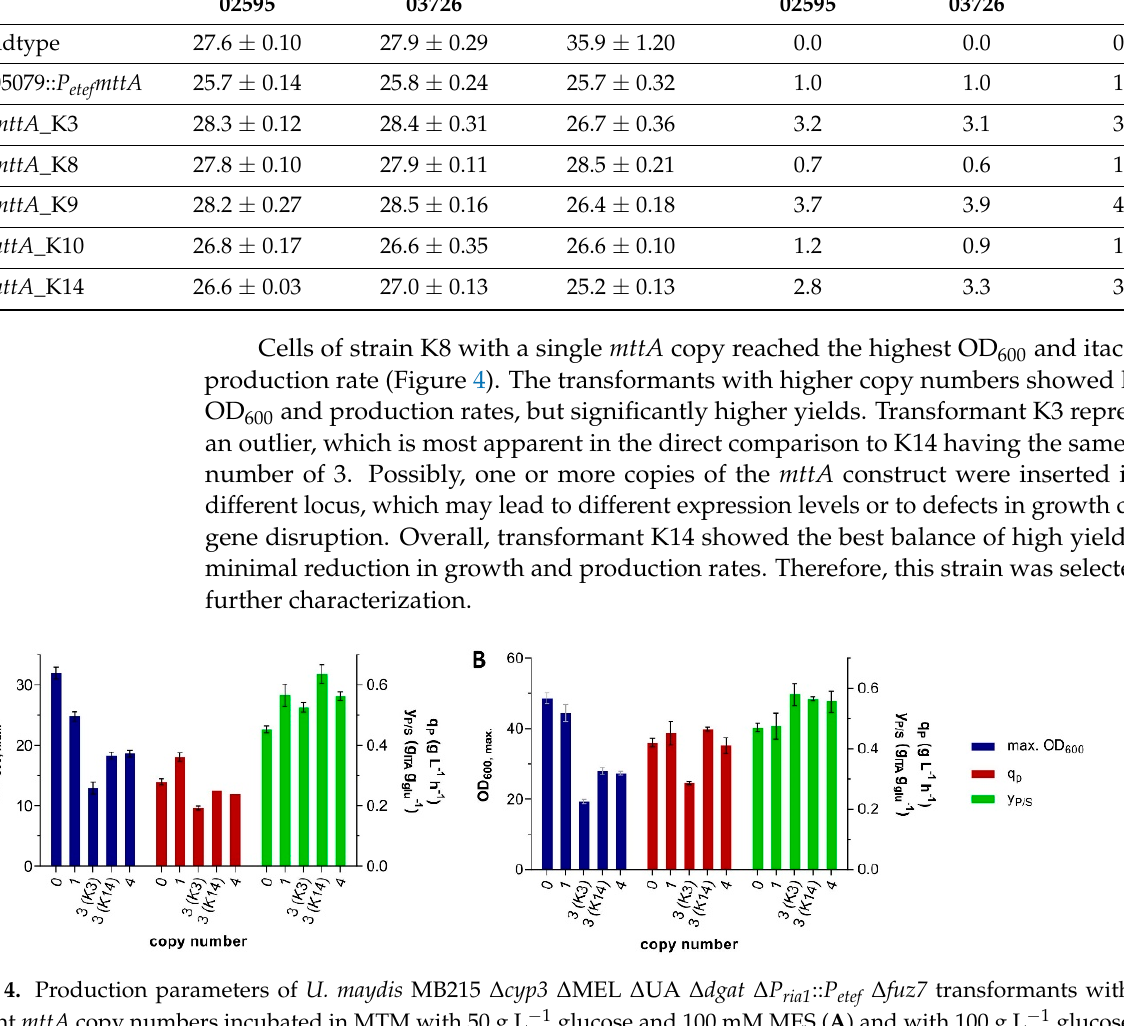
Table 4. Determination of P etef mttA copy number in five U. maydis MB215 ∆ cyp3 ∆ MEL ∆ UA ∆ dgat ∆ P ria1 :: P etef ∆ fuz7 P etef mttA transformants by quantitative polymerase chain reaction (PCR). ±values indicate the standard error of the mean ( n = 3).